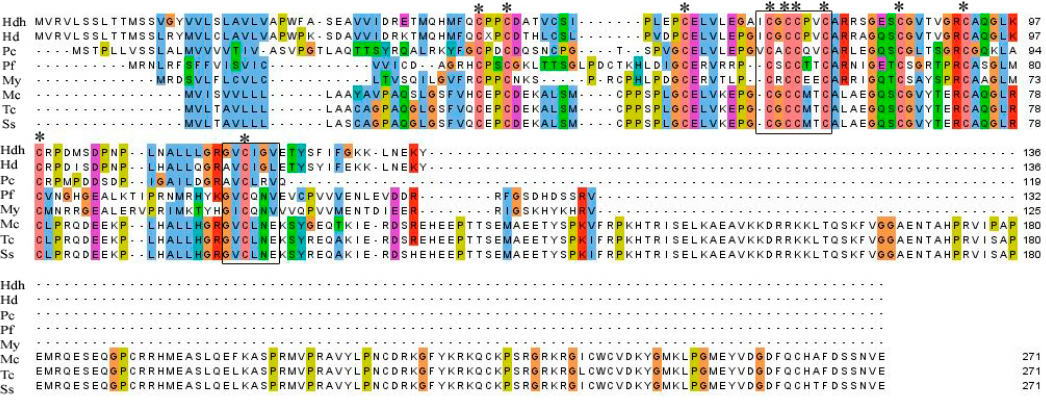
Figure 2. Multiple sequence alignment of amino acid sequences of Hdh IGFBP-5 with representative vertebrate and invertebrate homologs. Conserved motifs are indicated by black boxes. Conserved cysteine residues are marked with asterisks. Hdh– H. discus hannai , Hd– H. diversicolor (AFY98847.1),